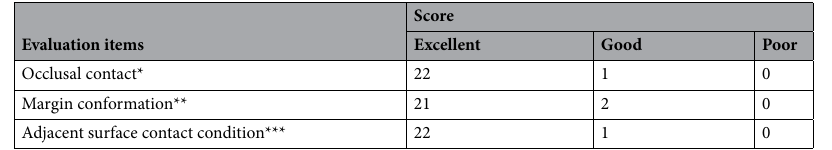
Table 3. Conditions of PEEK crown in the oral cavity at the time of cementing. *Excellent: ideal occlusal condition, Good: needs slight adjustment but generally good, Poor: needs extensive adjustment or too